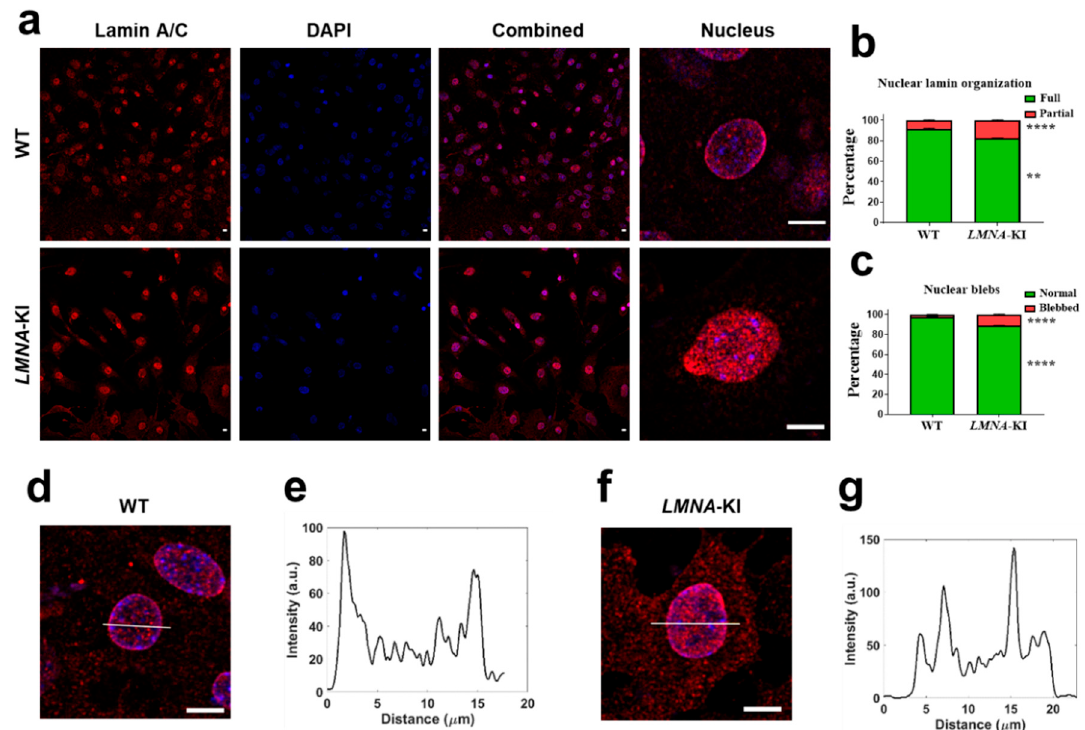
Figure 4. Lamin staining of cardiomyocytes differentiated from WT and LMNA -KI mES cells. WT mES cells and LMNA -KI mES cells were differentiated into cardiomyocytes and on day 12 stained with lamin antibody and DAPI (panels a , d , f ). Additionally, nuclear lamin organization ( b ) and nuclear blebs ( c ) were quantified by counting the cells per field of the 40 × microscopic view. Figures are representative of fully ( e ) or partially ( g ) organized nuclear lamin. Scale bar: 10 μ m. An unpaired t -test was used. Data are shown as mean ± SEM (n = 80). **** p < 0.0001, ** p < 0.01.